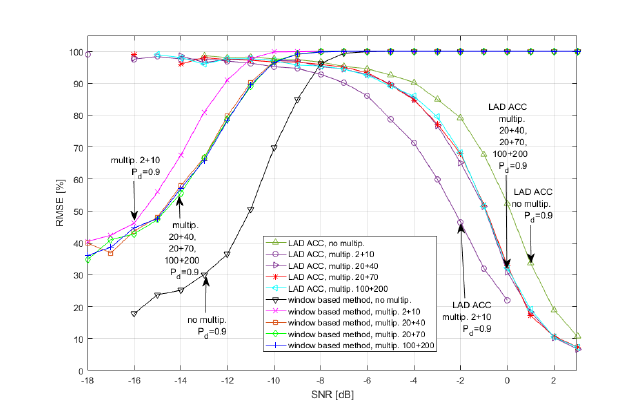
Figure 10. RMSE vs. SNR results in the presence of multipath components. BW of the signal is 10% and M = 102